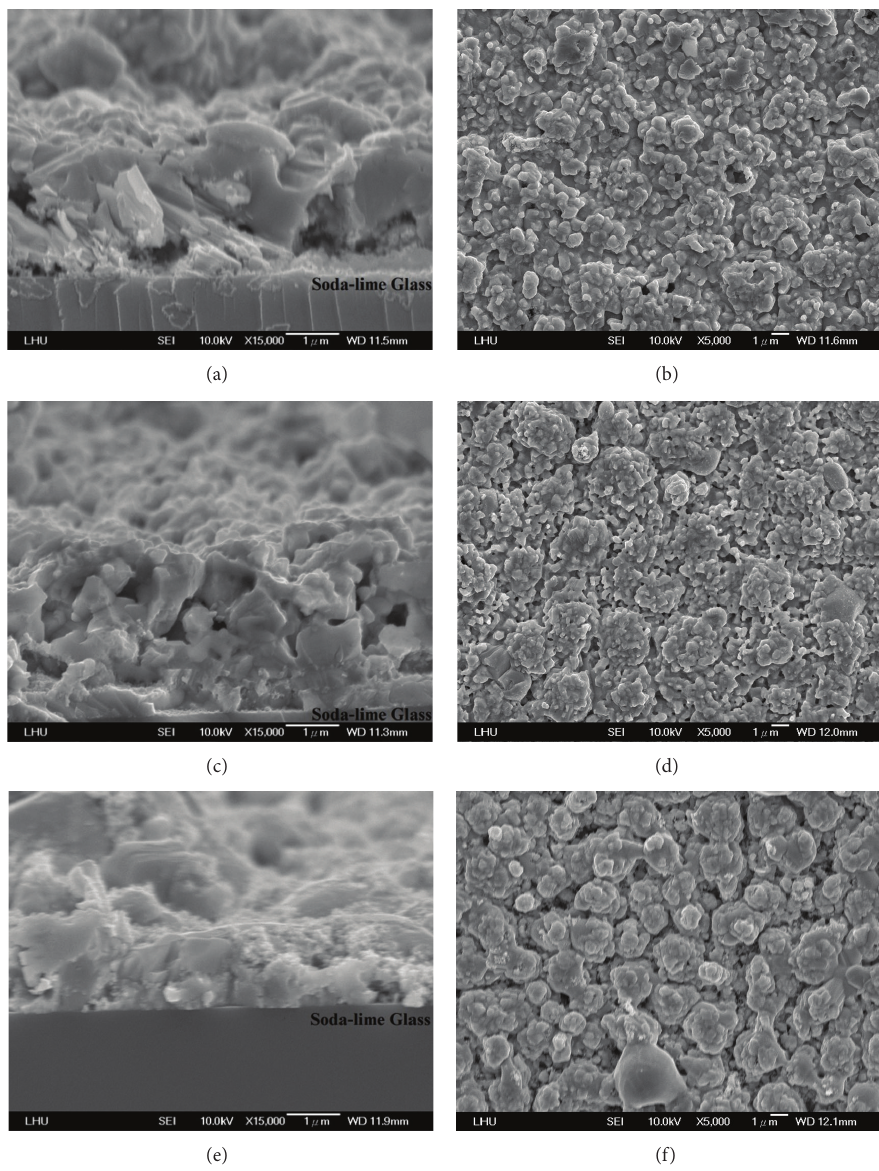
Figure 8: Cross-sectional and top-view SEM images of CIGS films made using (a), (b) the lowest (60 ∘ C/min), (c) and (d) 120 ∘ C/min, and (e) and (f) the highest heating rate (240 ∘